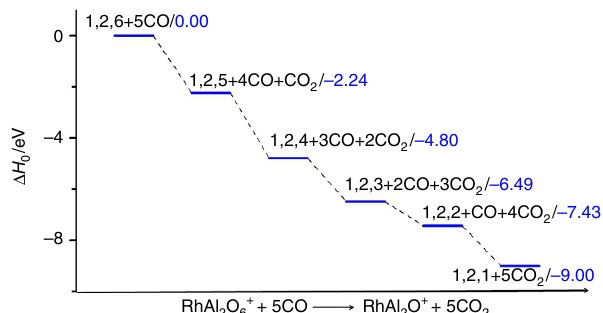
Figure 4 | Reaction thermodynamics. Density functional theory (DFT)- calculated thermodynamic data for CO oxidation by RhAl 2 O 2–6 þ . The energies are zero-point vibration-corrected in unit of eV.